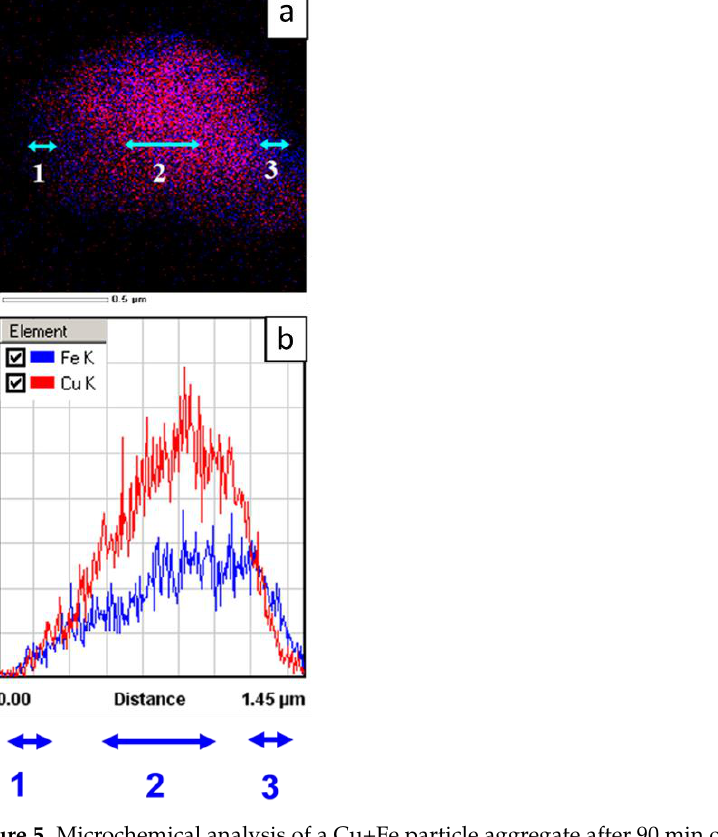
Figure 5. Microchemical analysis of a Cu+Fe particle aggregate after 90 min of milling ( a ) superposi- tion of the EDX maps of combining Fe and Cu showing the flat projection of the element distributions inside the particle ( b ) intensities of Fe K and Cu K signals along the directions marked in ( a ) (averaged over the width of the band). Table 3. Cu and Fe contents in flat projections are marked in Figure 6a. The linewidth is 130 eV.